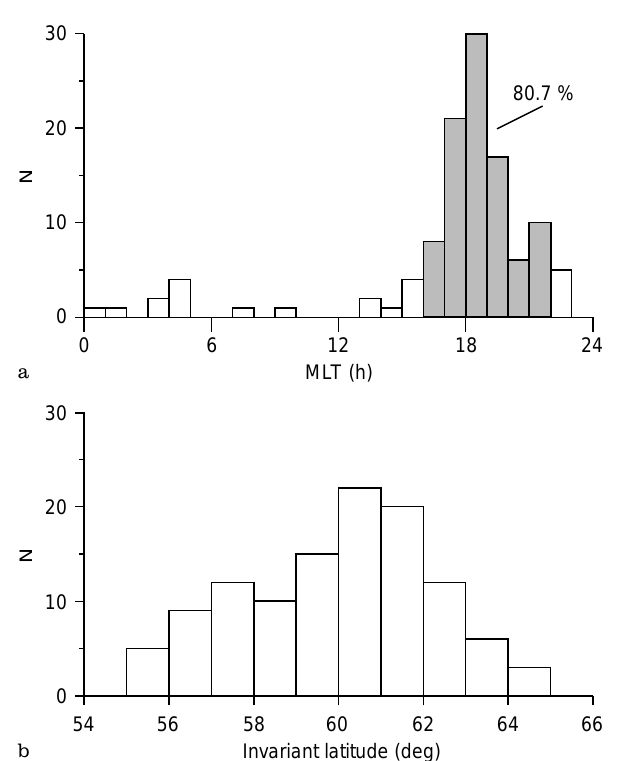
Fig. 3a,b. Occurrence of the cli(cid:128) phenomena at a MLT and b invariant latitude